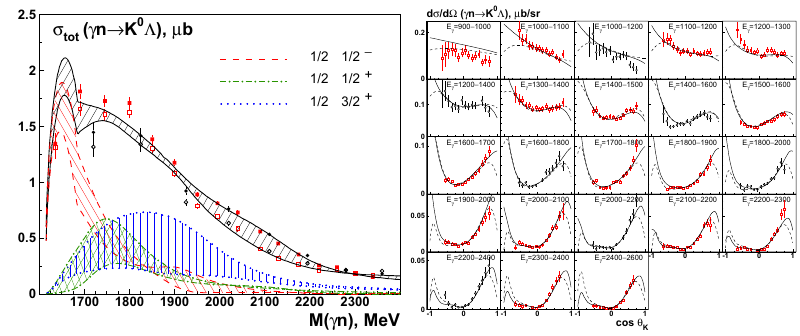
Figure 3. The contributions of the leading partial wave to the γ n → K 0 Λ total cross section and the description of the di ff erential cross section [9] with two found solutions.